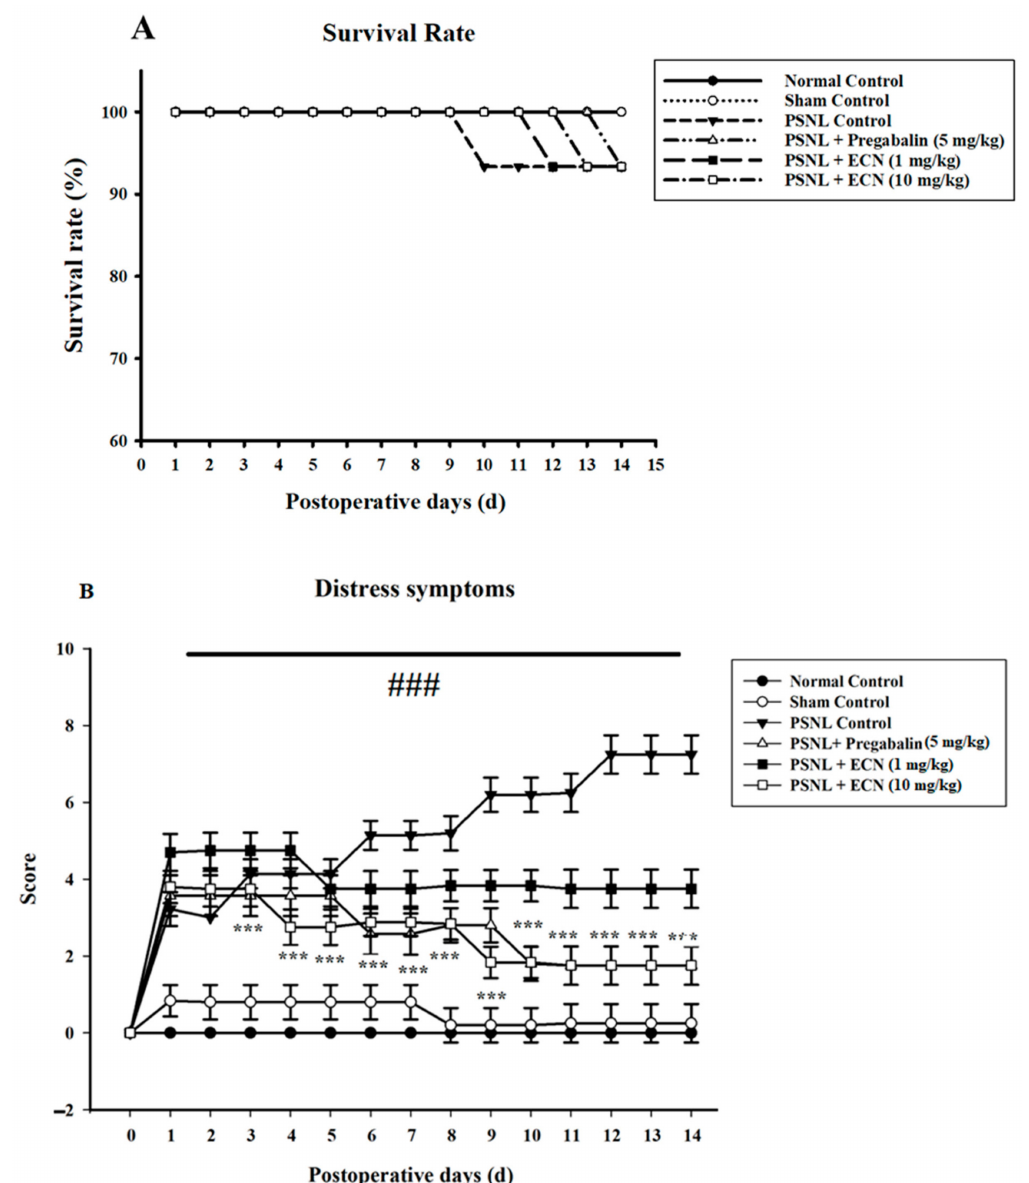
Figure 1. Effect of ECN treatment on survival rate and distress symptoms. ( A ) Survival rate during the experiment. Data are presented as a percentage of number of mice survived each day. ( B ) Effect of ECN (1 and 10 mg/kg i.p.) treatment on distress symptoms. The total score of distress symptoms (dull/ruffled coat, change in temperament, reluctance to move) were recorded daily. Each criteria was scored from (0–3). The p > 0.001 value has been calculated from actual raw counts by applying two-way ANOVA followed by Dunnett’s t-tests. The average and standard deviation of actual counts were expressed in the percentages using the standard formula. Different letters meant statistically significant differences: (***) p < 0.001 indicate significant differences from the PSNL control group. (###) indicate significant differences from the normal control group. *** p < 0.001 (two-way ANOVA followed by Dunnett’s